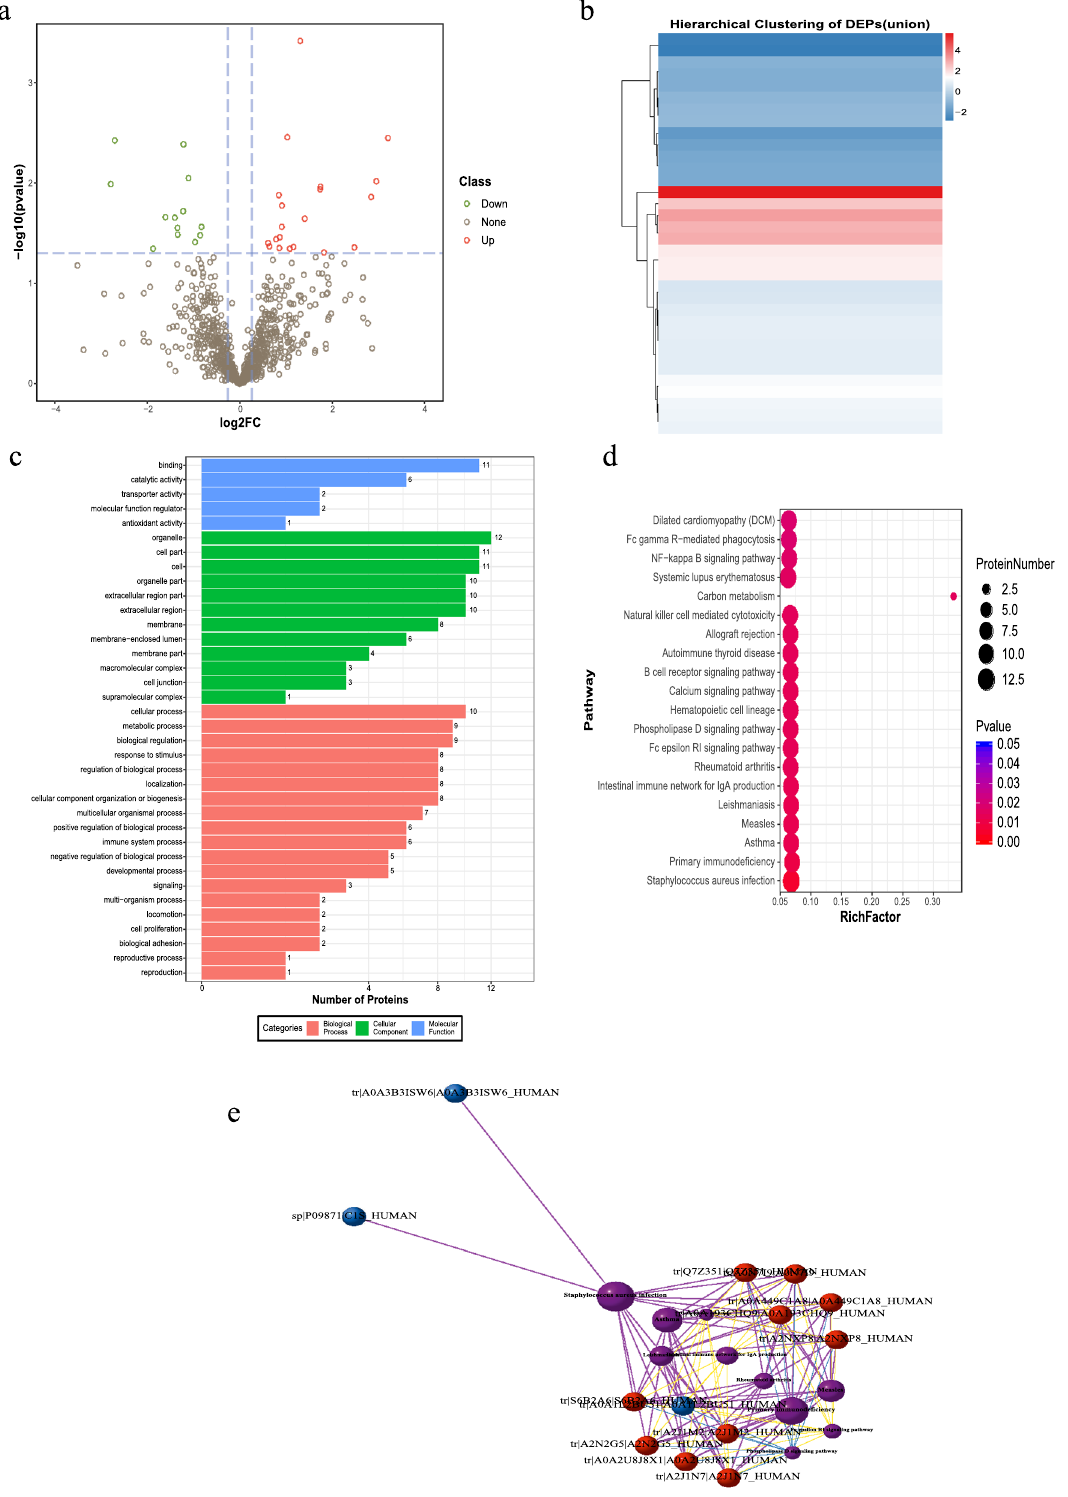
Figure 5. Differentially expressed proteins (DEPs) were identified and analyzed using proteomics in Covid-19 patients with progressive pulmonary fibrosis. ( a ) Volcano plots of total protein level. ( b ) Cluster chart of DEPs. ( c ) Enrichment analysis of DEPs by GO function. ( d ) Bubble plot of the top 20 KEGG enrichment pathways of DEPs. RichFactor is defined as the number of differential metabolites annotated to the pathways divided by all identified metabolites annotated to the pathway. ( e ) Pathway network of DEPs (“igraph” package in R software v3.5.0, https:// www.r- proje ct. org/). The red and blue dots represent up-regulated and down-regulated differential proteins, respectively. The purple balls represent the top 10 pathways of enrichment. The area is directly proportional to the enrichment